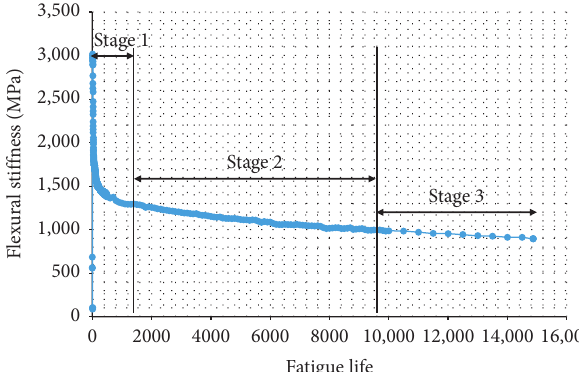
Figure 3: Pattern of change in hardness modulus versus loading cycle.